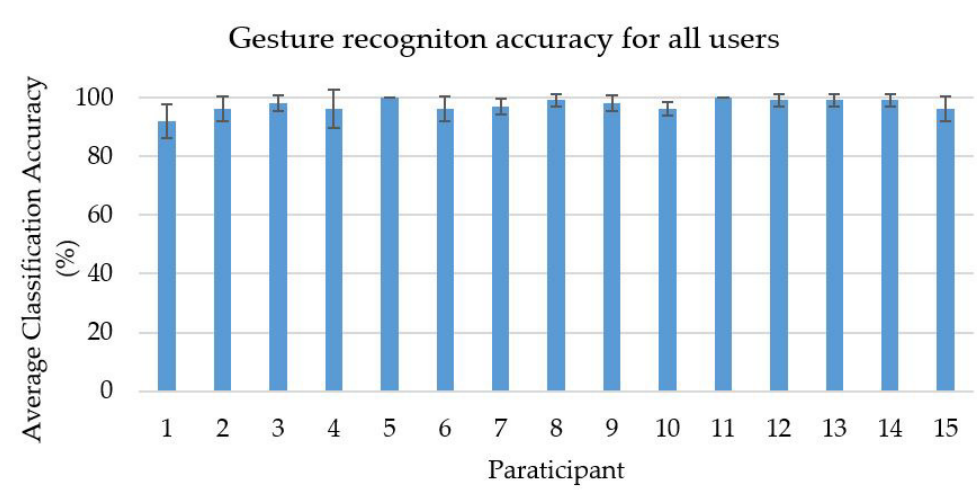
Figure 19. Average accuracy of the gesture recognition of all